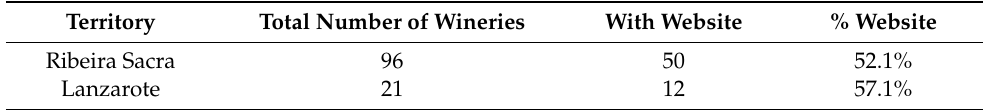
Table 4. Wineries of the DD.O. Ribeira Sacra and Lanzarote with a website.